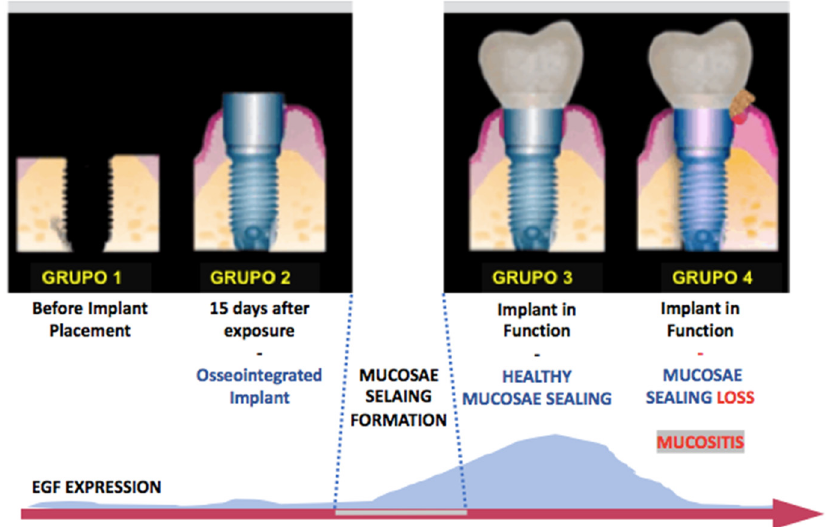
Figure 4. EGFR gene expression in groups 1, 2, 3, and 4, showing no statistical difference.